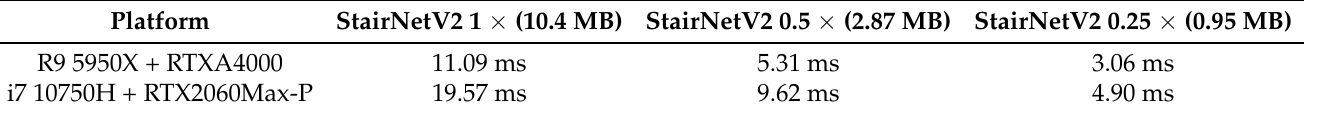
Table 4. Platforms, parameter quantities of the models, and inference speeds.